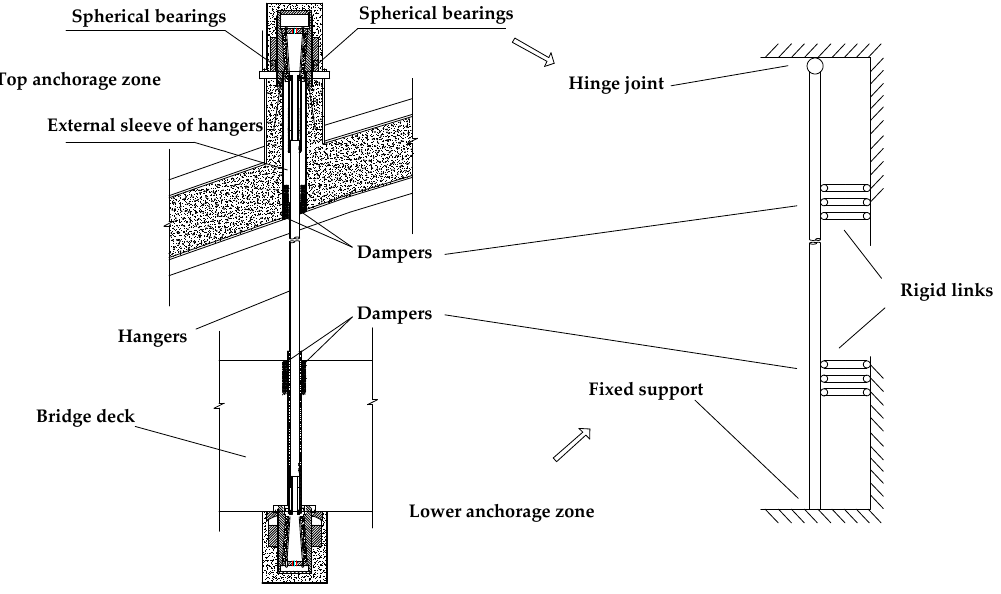
Figure 3. Boundary conditions of the